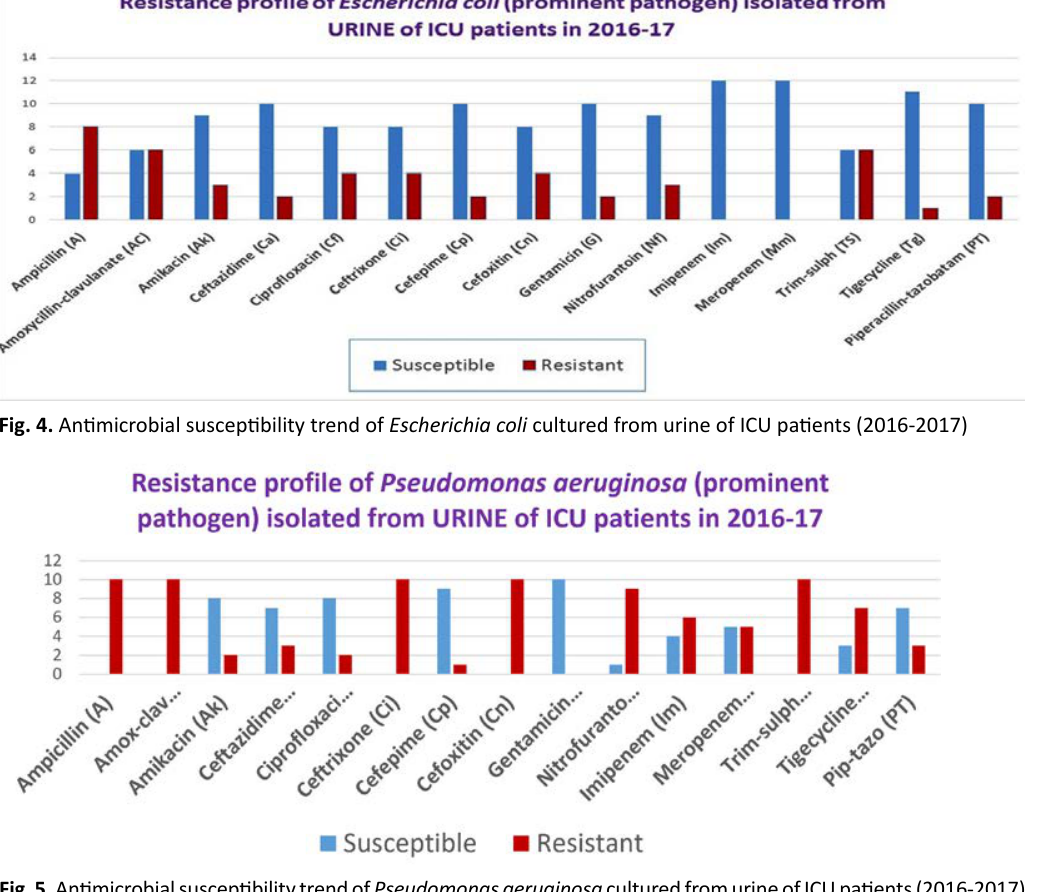
Fig. 5. Antimicrobial susceptibility trend of Pseudomonas aeruginosa cultured from urine of ICU patients